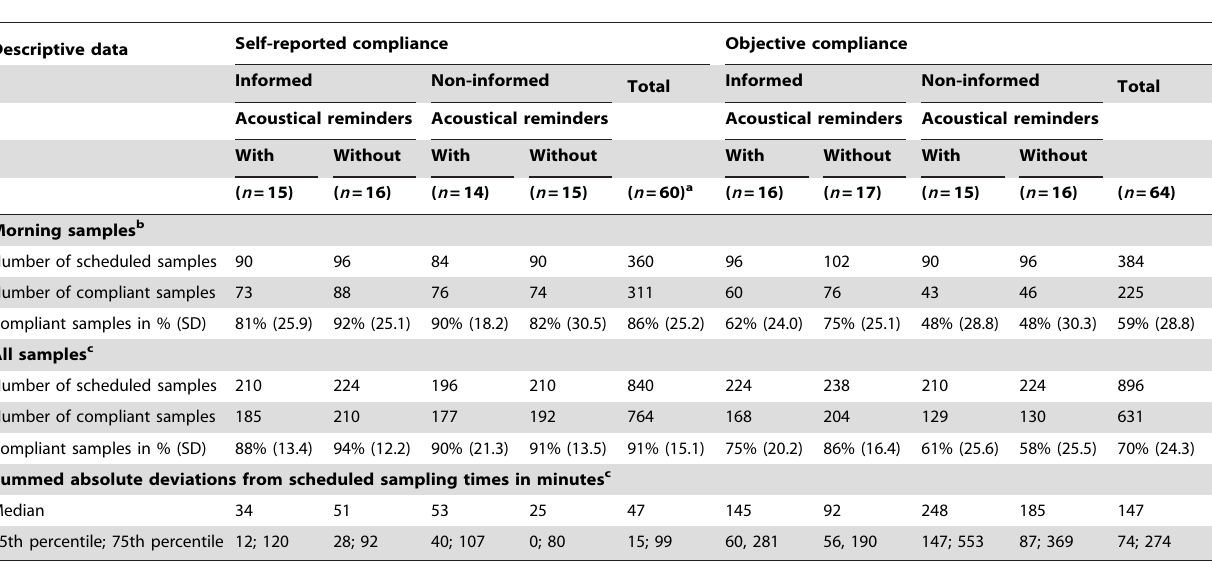
Table 2. Self-reported and objective compliance with scheduled saliva sampling across experimental groups.